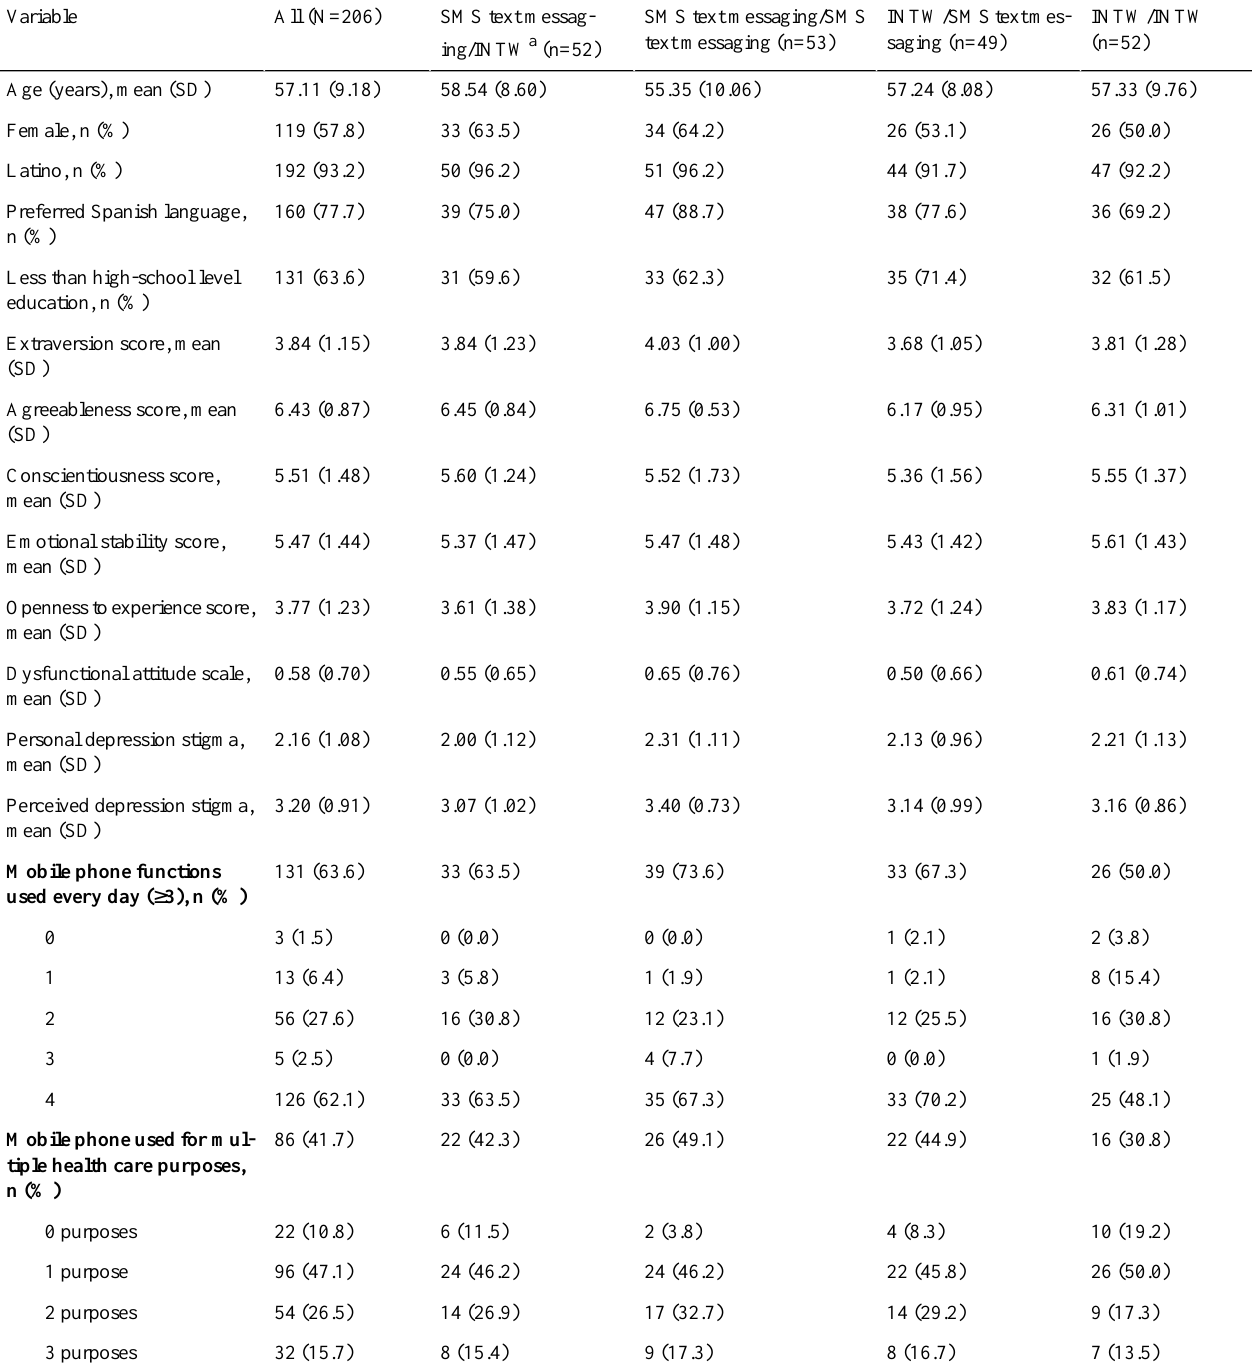
Table 1. Summary of the participant